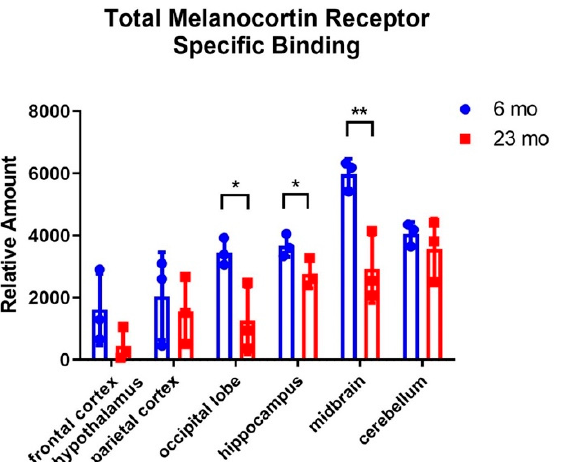
Figure 2. Total melanocortin receptor specific binding of [ 125 I]-NDP-MSH to different brain regions of 6 mo ( n = 6) and 23 mo ( n = 6) rats. Statistical significance was calculated by a Student’s t-test. * indicates p < 0.05. ** indicates p < 0.01.